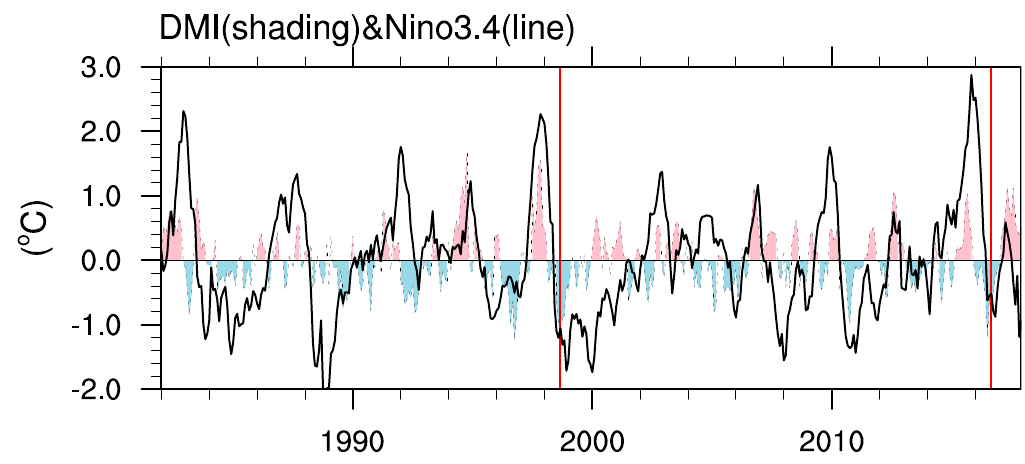
Figure 1. Time series of monthly Niño3.4 index (black solid line) and dipole mode index (shading) during 1982–2018. Red lines indicate August 1998 and August 2016.